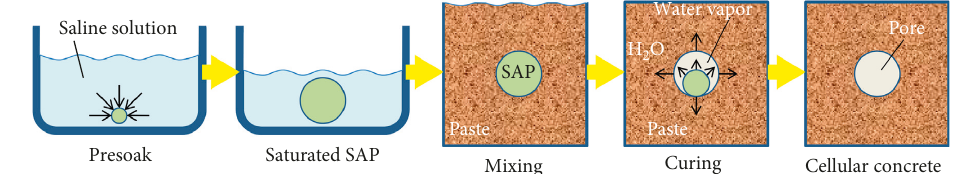
Figure 1: A schematic of the fabrication process of cellular concrete (arrows represent the flow direction of water and vapor)